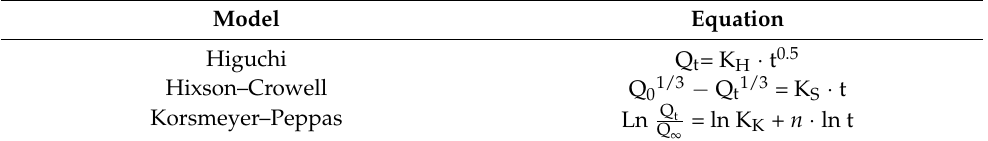
Table 1. Mathematical models used for adjusting the diffusion data obtained from a vertical Franz diffusion